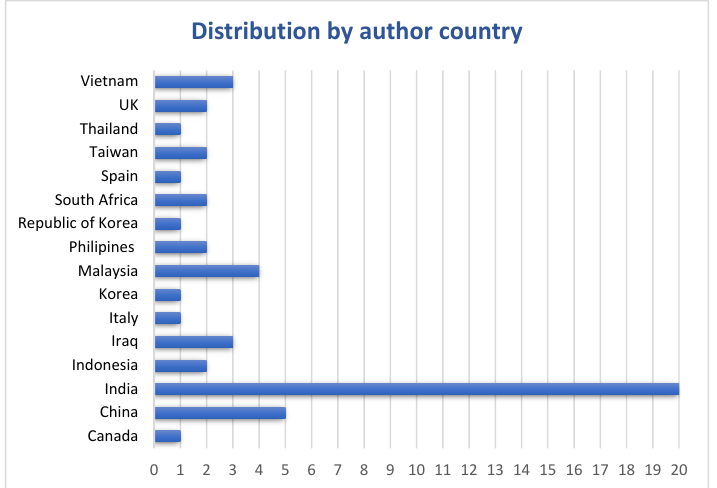
Figure 5. Distribution by country of author.